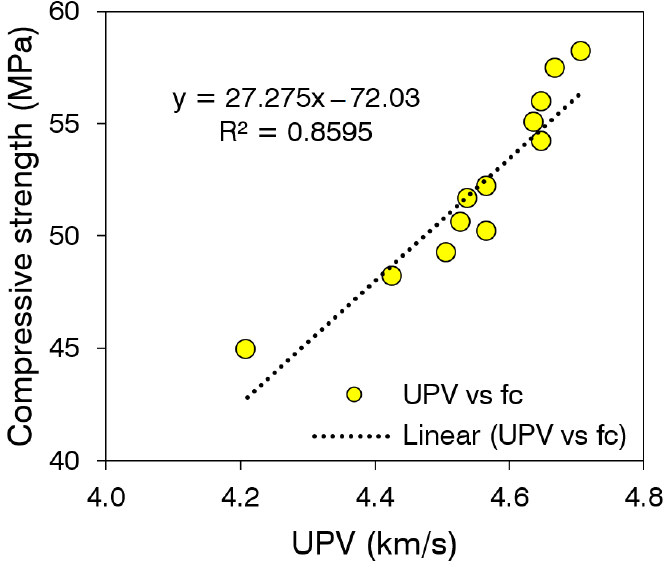
Figure 14. Correlation between corresponding values of UPV and compressive strength.